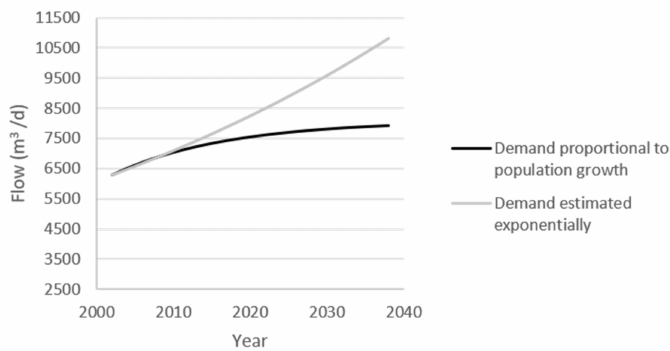
Figure 2. Estimated